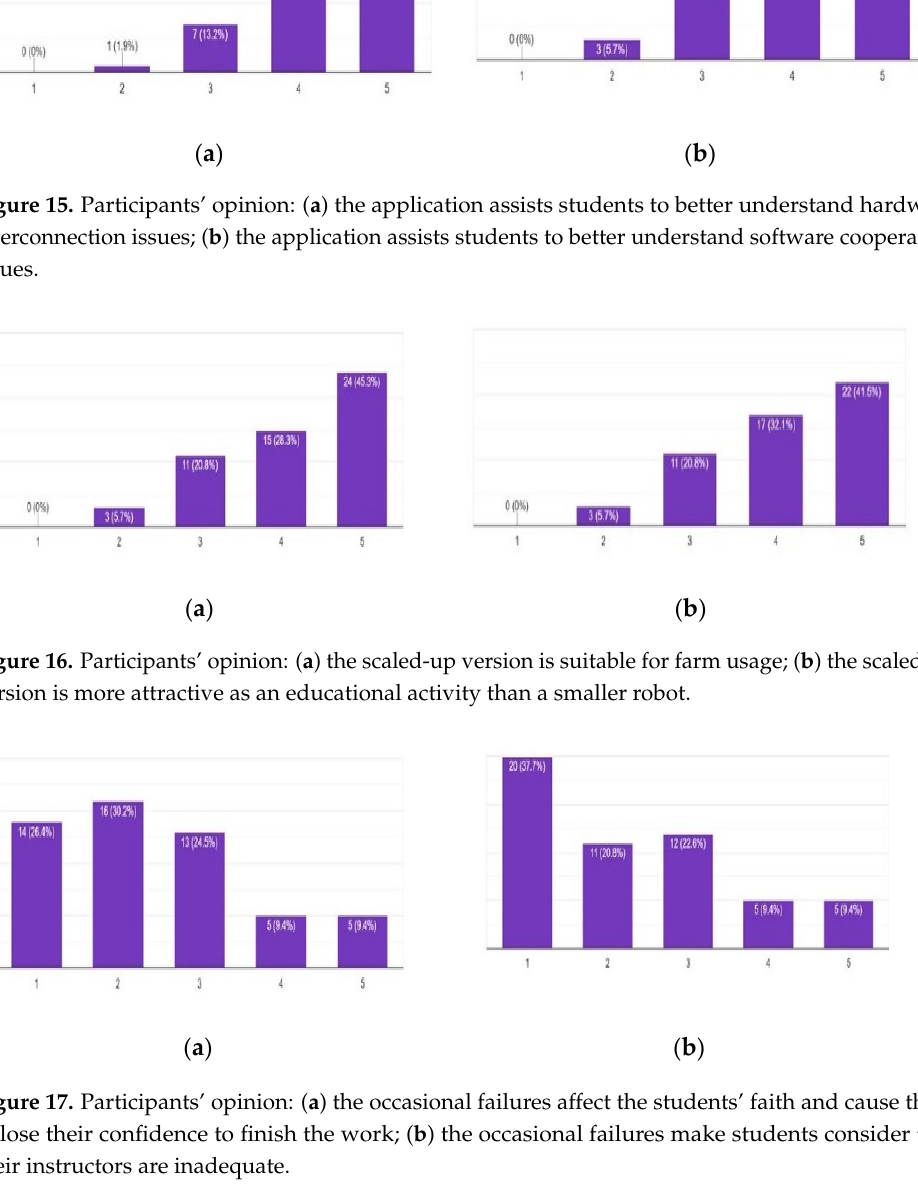
Figure 18. Participants’ opinion: ( a ) the teamworking experience enhances students’ self-esteem; ( b ) the teamworking experience results in team bonding.